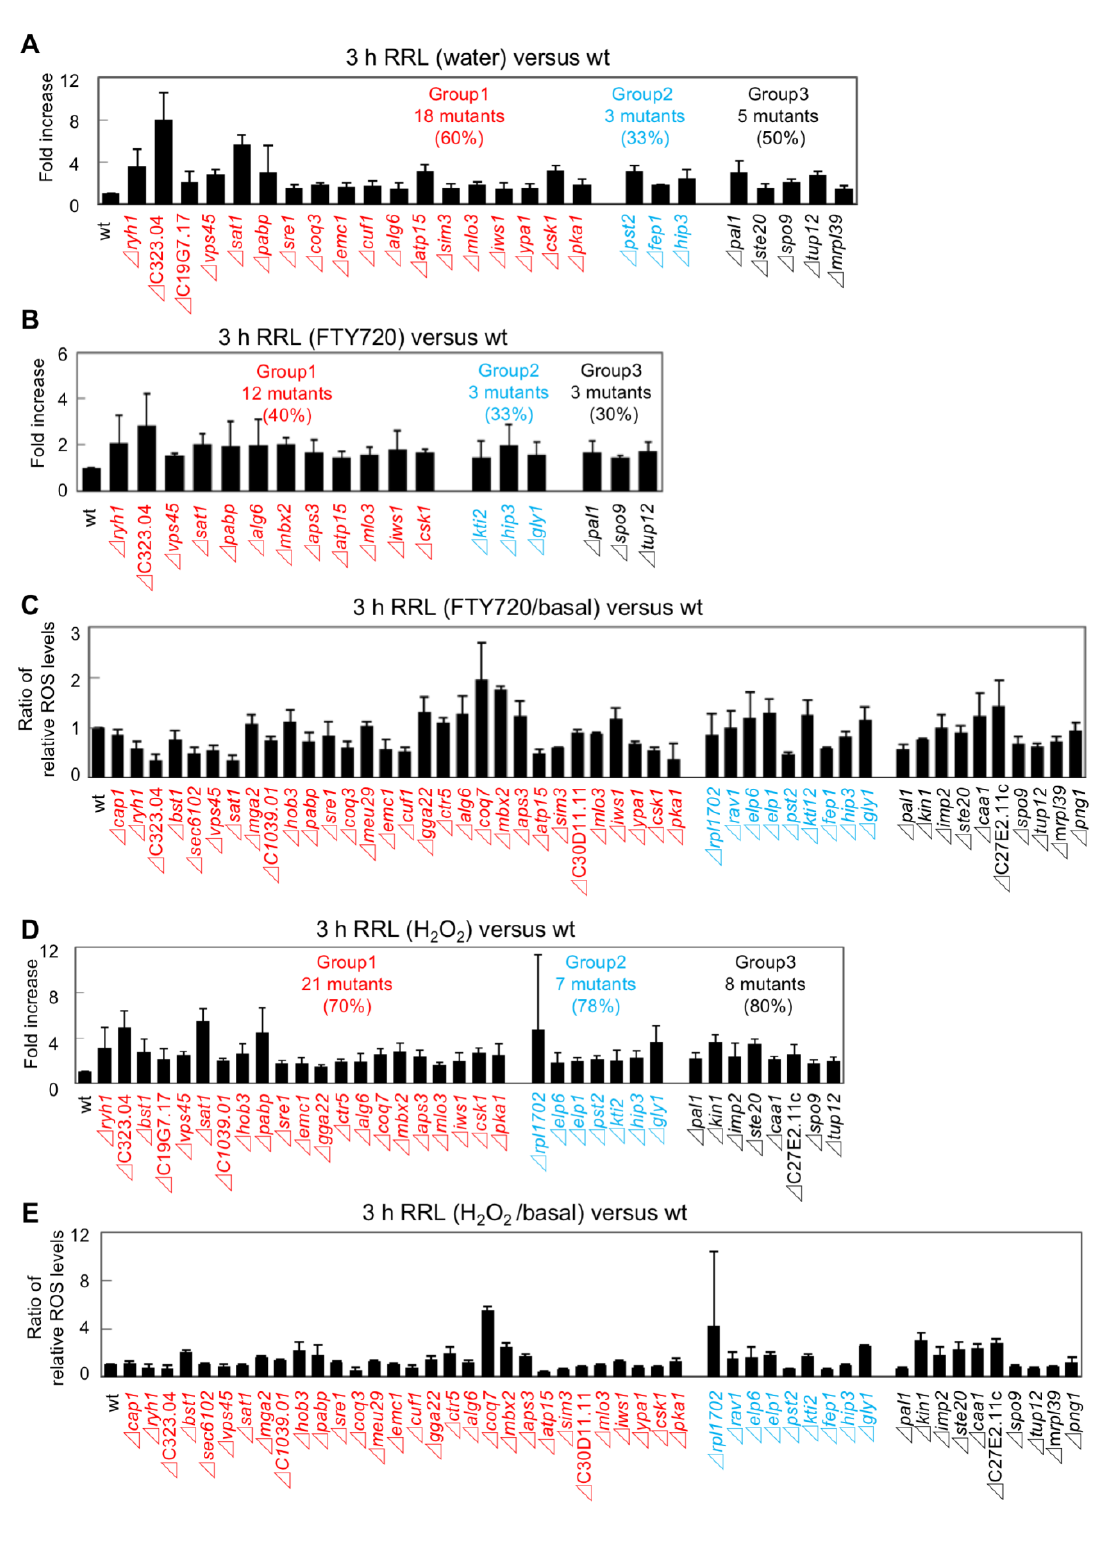
FIGURE 6: FTY720-sensitive gene-deletion cells exhibited deregulated ROS levels in the absence/presence of FTY720 or H 2 O 2 . (A) The RRL in the 26 FTY720-sensitive mutants displayed 150% higher than that in the wt strain in the absence of any ROS-inducing agents. (B) The RRL in the 18 FTY720-sensitive mutants displayed 150% higher than that in the wt strain upon FTY720 treatment. (C) Ratios of ROS levels be- tween after and before the FTY720 stimuli in comparison with those of the wt strain. (D) The RRL in the 36 FTY720-sensitive mutants dis- played 150% higher than that in the wt strain upon H 2 O 2 treatment. (E) Ratios of ROS levels between after and before the H 2 O 2 stimuli in comparison with those of the wt strain. These ROS accumulations were measured for 3 h. The data were averaged from three independent experiments. Error bars,